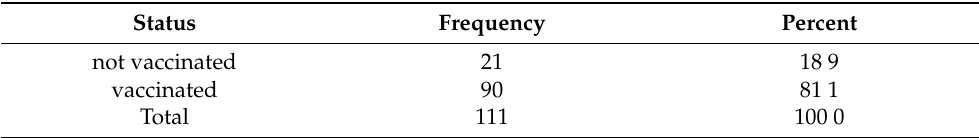
Table 1. Vaccination status of all